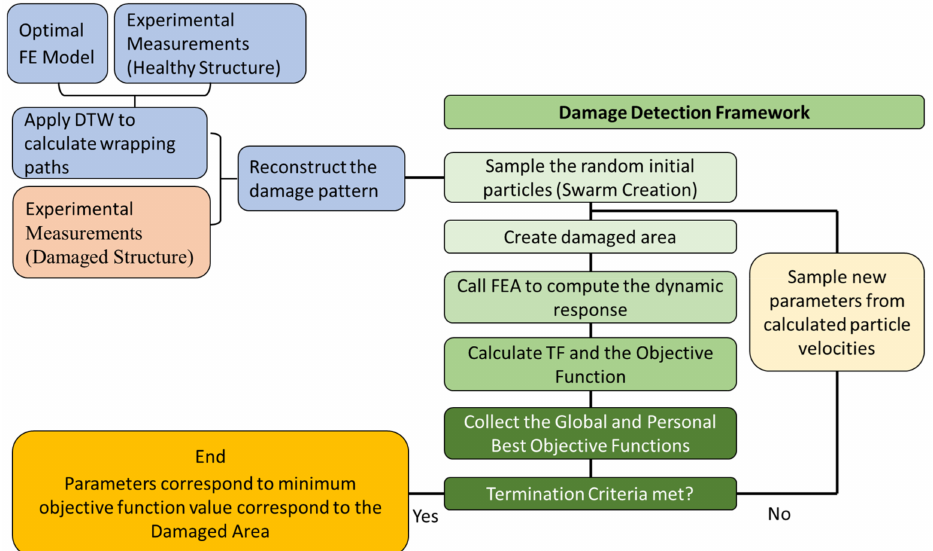
Figure 2. Flow chart of the proposed Damage Detection Framework.